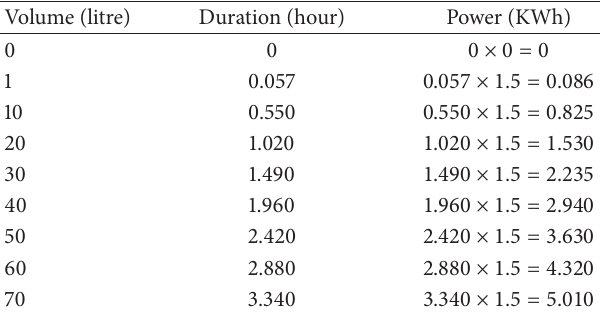
Figure 5: Inlet and outlet temperature for the average values at different angles. Table 11: Operation of a 1.5 KW electric heater heating water to 85 ∘